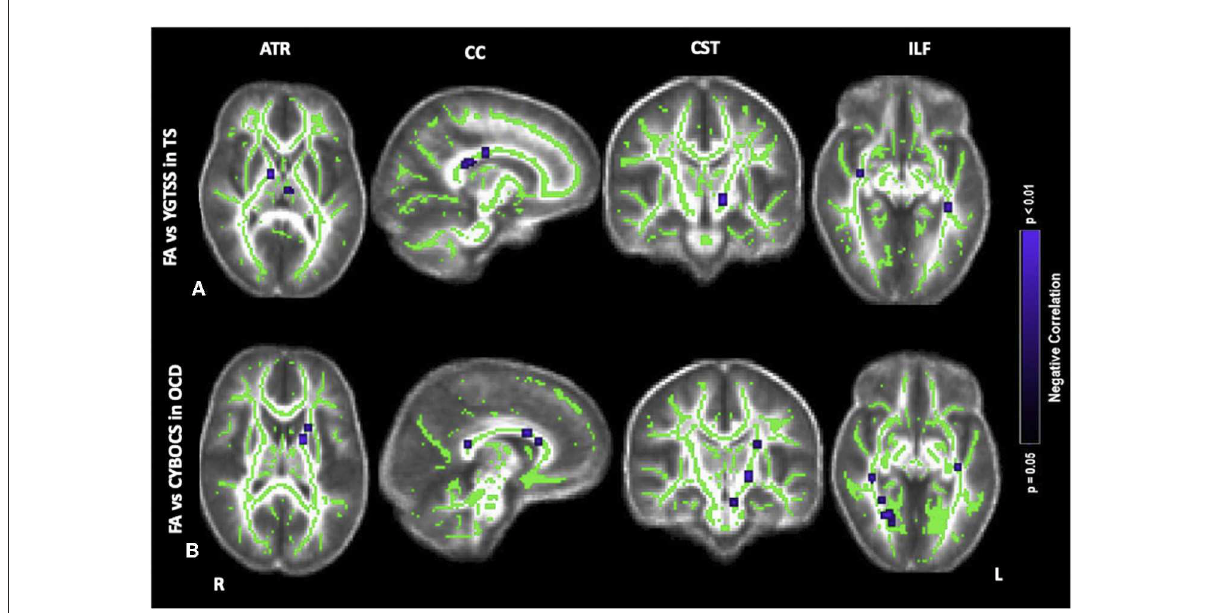
FIGURE2 Correlations of fractional anisotropy (FA) abnormalities in (A) TS with YGTSS, (B) OCD with CYBOCS at the anterior thalamic radiation (ATR), corpus callosum (CC), corticospinal tract (CST), inferior longitudinal fasciculus (ILF). Results were obtained within the mask of ATR, CC, CST, and ILF. Results are presented in the whole brain FA skeleton mask derived from the complete set of participants. Results were corrected for multiple comparisons at the false discovery rate (FDR) of p < 0.05. Blue color: Negative correlation, TS: participants with pure Tourette and